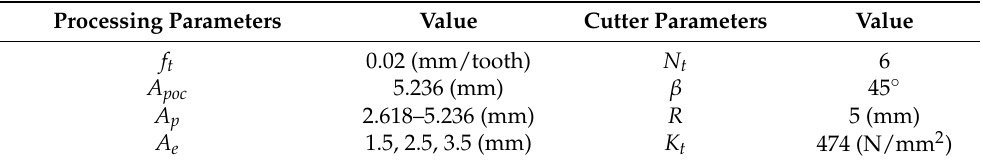
Table 1. Parameters for the force fluctuation simulation.